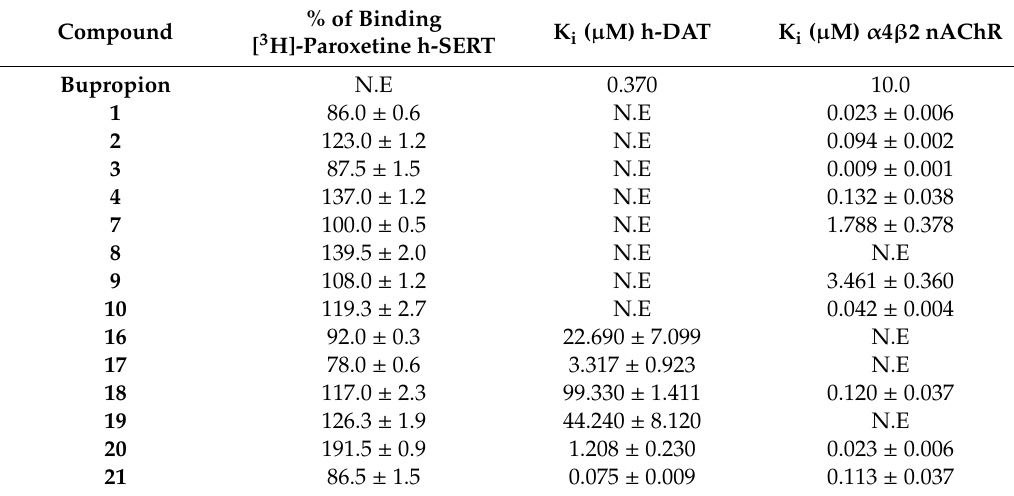
Table 1. K i values (μM) for the synthesized compounds against h -DAT, α 4 β 2 nAChRs and [ 3 H]- paroxetine h-SERT expressed as binding percentage. K i values ( µ M) for the synthesized compounds against h-DAT, α 4 β 2 nAChRs and [ 3 H]-paroxetine h-SERT expressed as binding percentage.